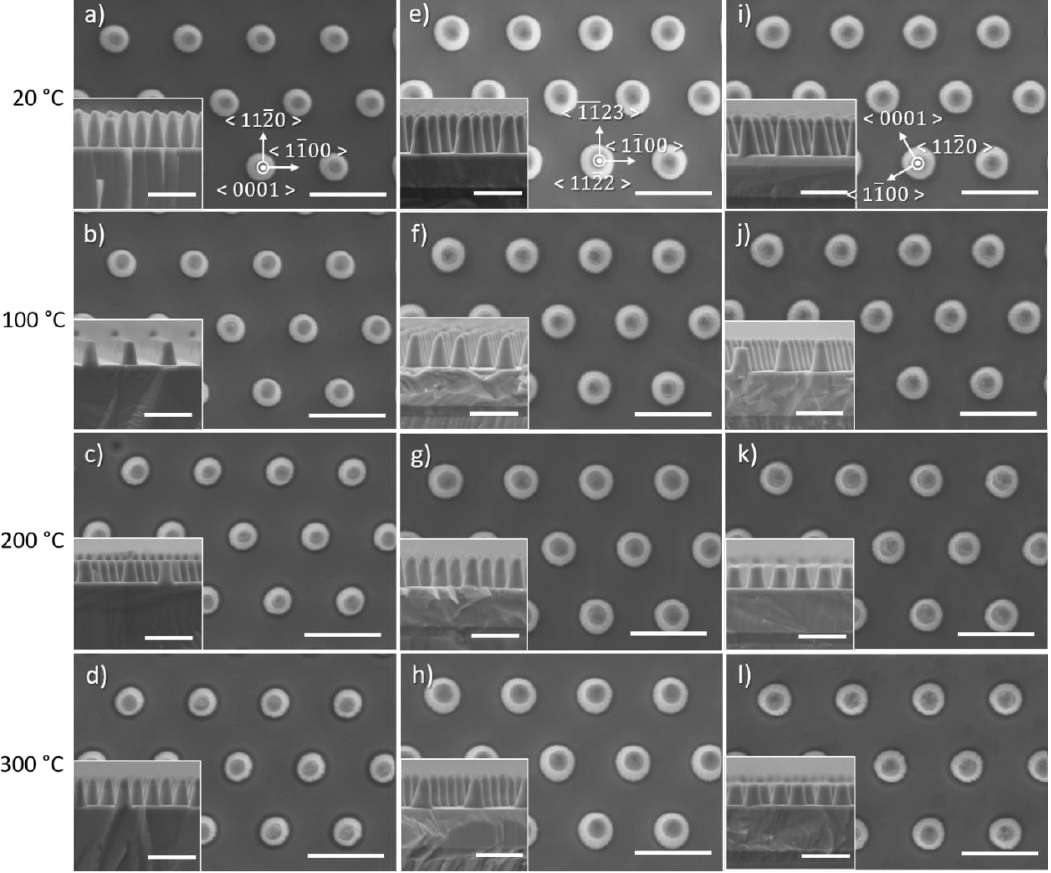
Figure 8. ( a ) Etch rate, ( b ) base diameter and ( c ) sidewall angle of c -plane, ( 112 ̅ 2 ) semi-polar and ( 112̅0 ) non-polar GaN layers as a function of temperature. Surprisingly, the etch rate decreases with an increase of temperature, while the base diameter remains constant and the sidewall angle increases. The volatility of GaCl x etched by-products is expected to be temperature dependent [25]. However, the increase of the substrate temperature could also potentially increase the desorption of Cl 2 on the etched surface, leading to a lower etch rate [26]. Our previous reports carried out under more chemical etching conditions, i.e high percentage of Cl 2 injected into the Cl 2 + Ar plasma and higher pressure, revealed that higher temperatures increase the etch rate and improve the verticality of the sidewall profile of the c -plane etched nanorods [24,25]. We previously discussed that chemical etching conditions lead to the morphology of the nanorod being highly dependent on the crystal orientation. If these conditions were to be employed and the